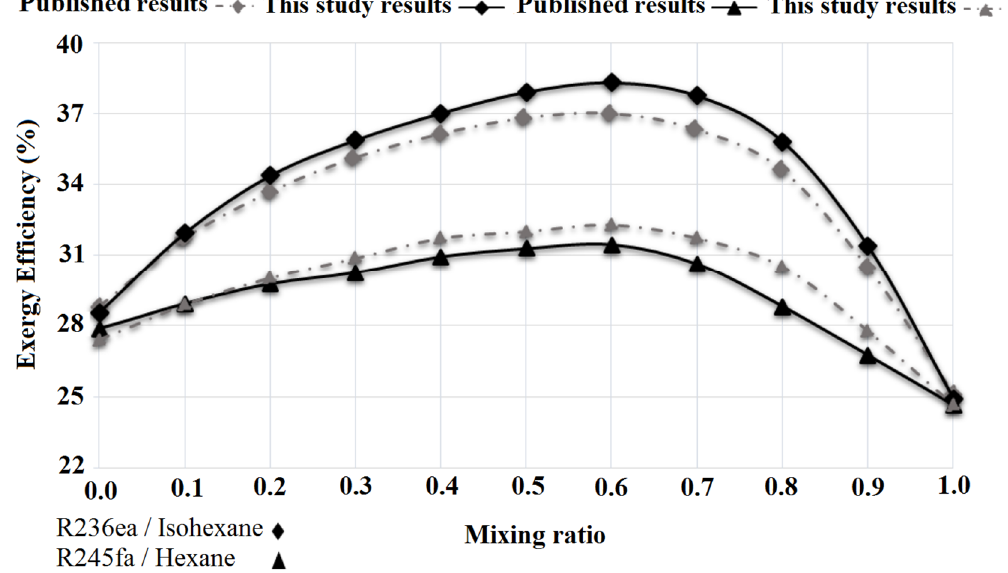
Figure 4. Comparison of the simulated exergy efficiency to the similar previously published data [29] for both R236ea/Isohexane and R245fa/Hexane working fluids.